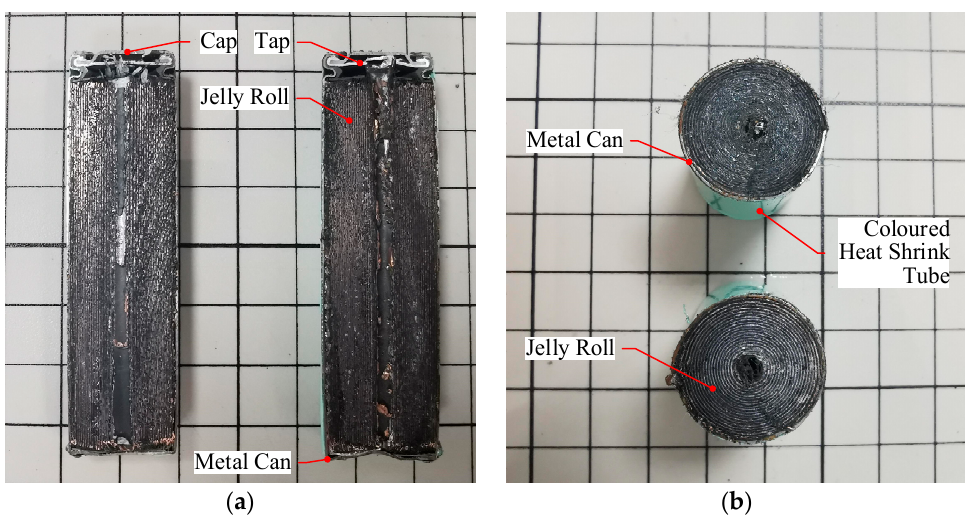
Figure 1. Internal structure of cylindrical cells: ( a ) longitudinal section ( b )